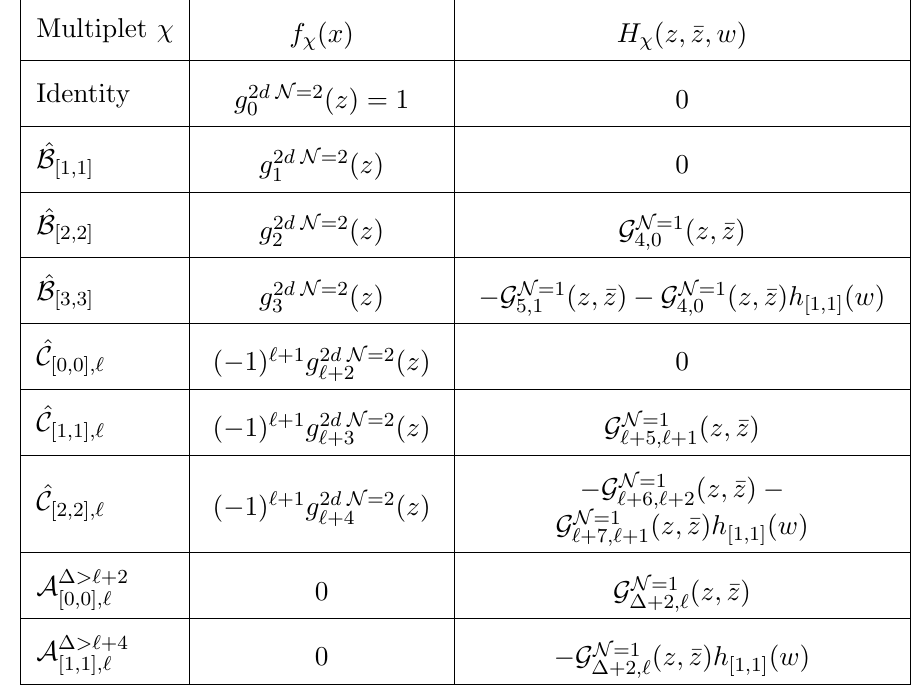
Table 6 . Contributions of the various N = 3 multiplets appearing in the non-chiral OPE (3.21), for R = 3, to the functions f (cid:31) ( x ) and H (cid:31) ( z; (cid:22) z; w ). Note that we can make the identi(cid:12)cation ^ C = ^ B , and in the text we take the latter to be a special case of the [ k;k ] ;‘ = (cid:0) 1 [ k +1 ;k +1]